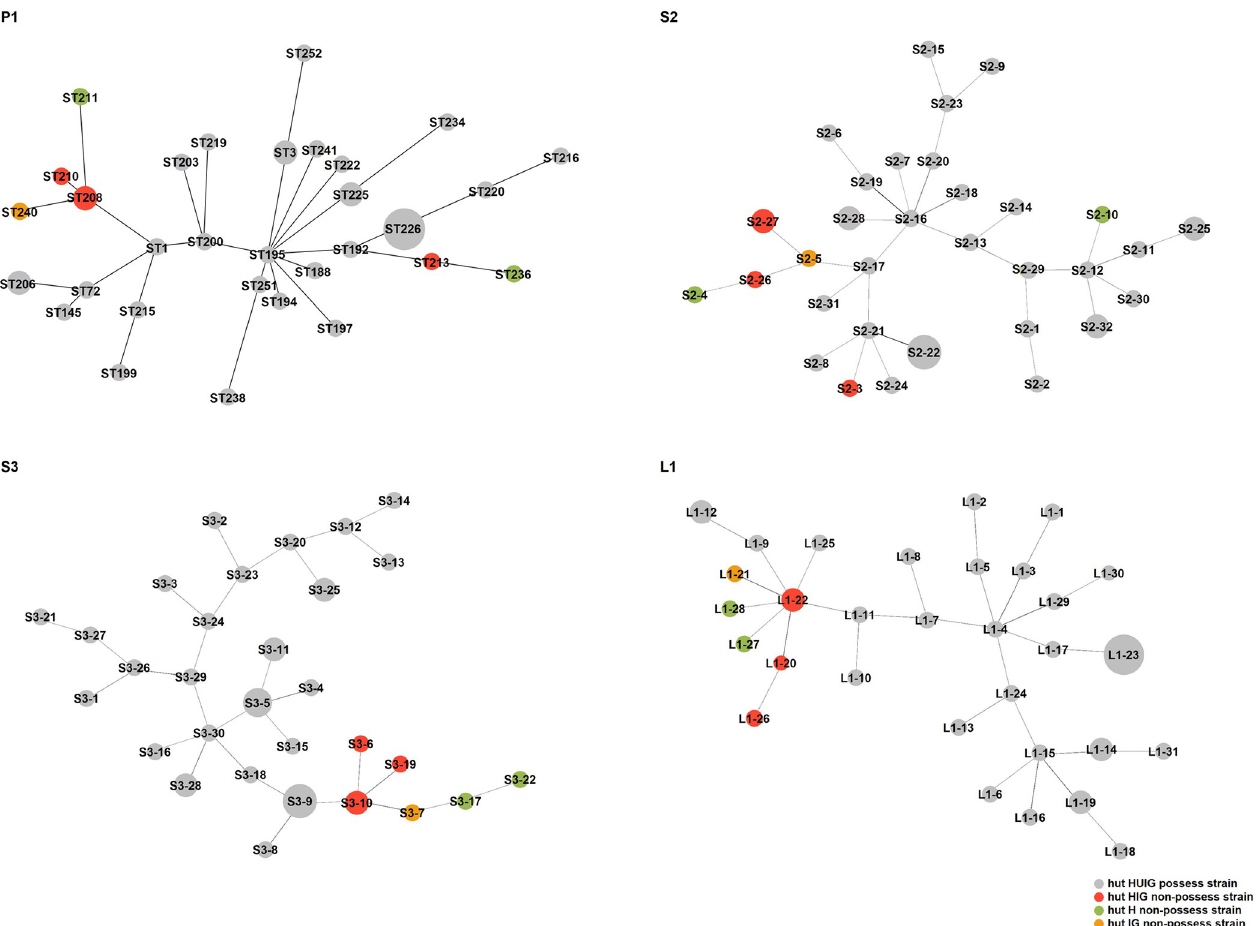
Fig 4. Minimum spanning trees for sequence types generated by four MLST methods. Numbers in the trees indicate STs. Circle sizes are proportional to the number of isolates belonging to that ST.